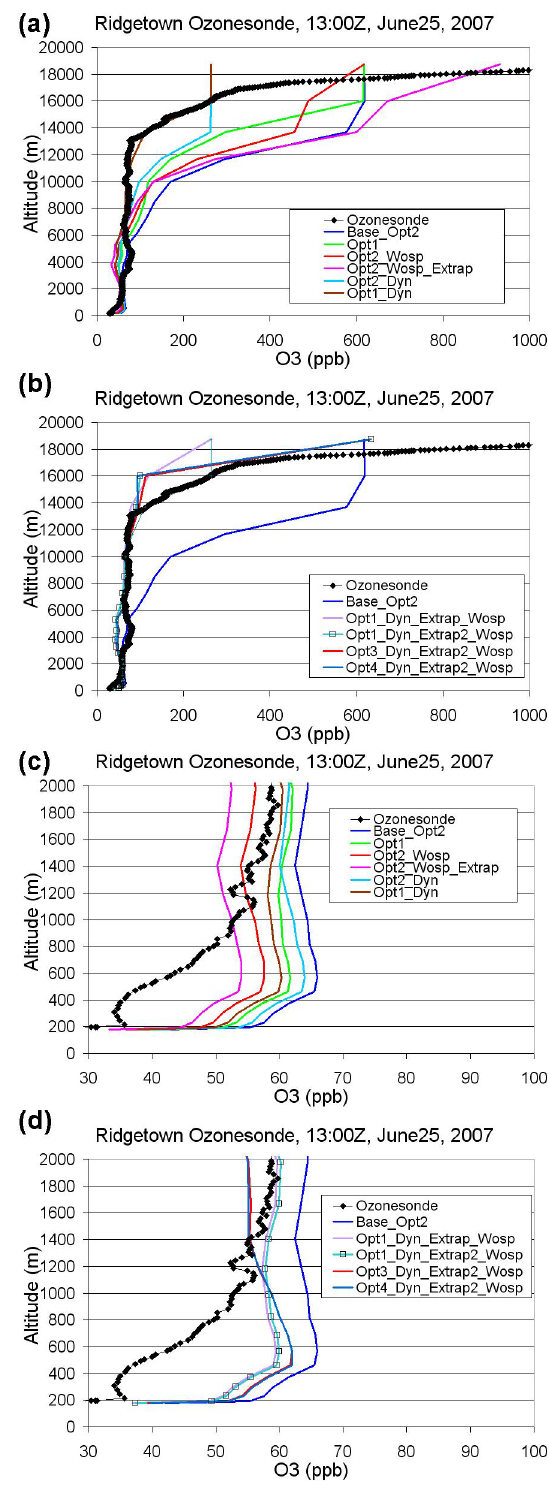
Fig. 6. (a) and (b) Comparison between observed ozone profile and 12km grid simulations, 00:40Z, 21 June 2007. (a) Entire model vertical domain, first five scenarios; (b) Entire model vertical do- main, second five scenarios. (c) and (d) : As in (a) and (b), lowest 2km of the atmosphere.